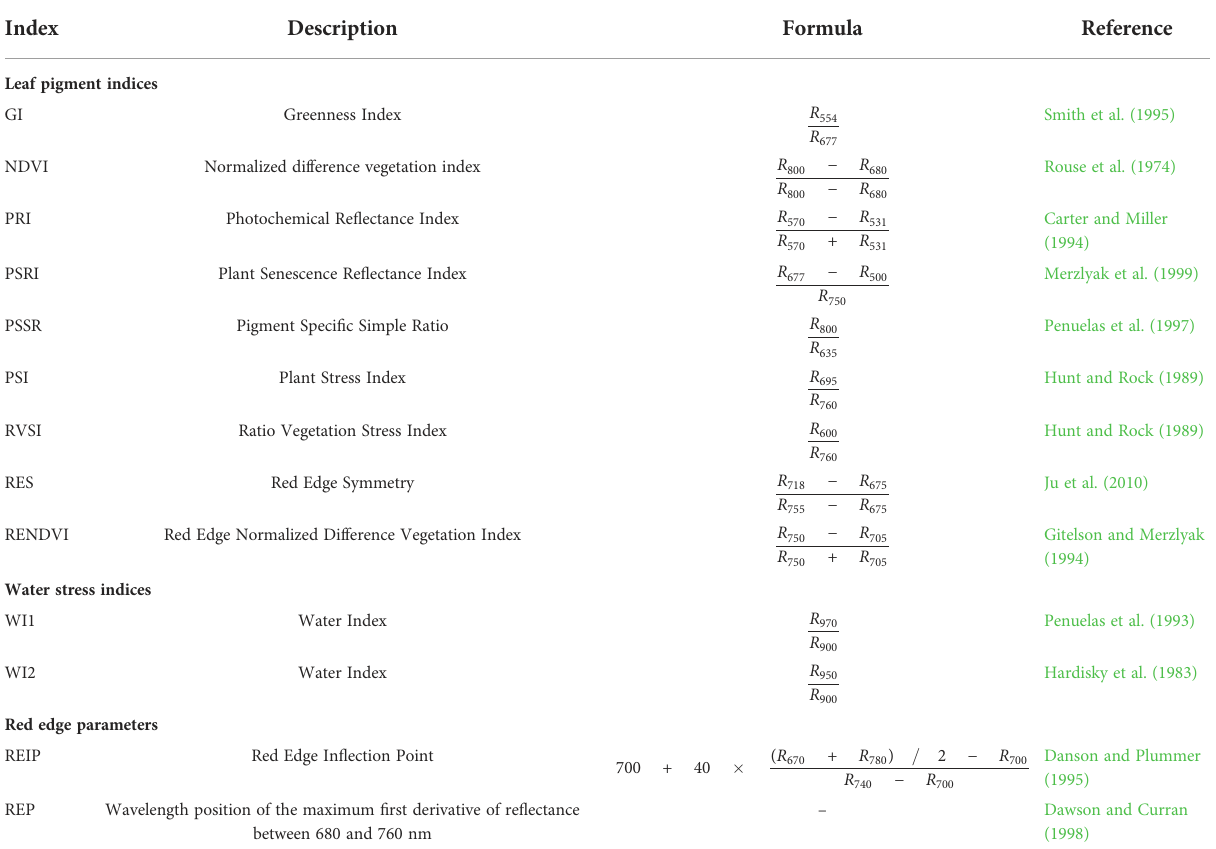
TABLE 2 Vegetation indices employed in the